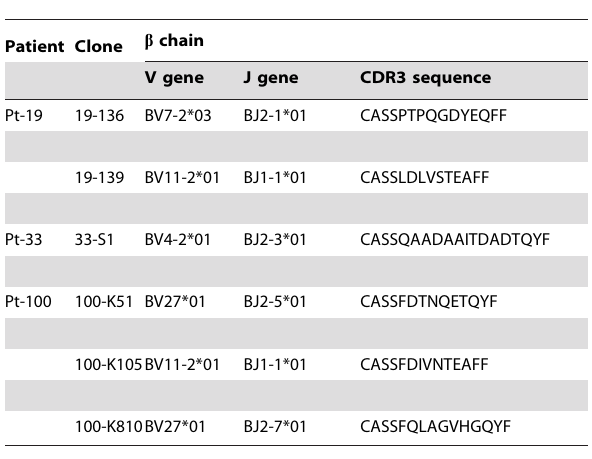
Table 2. TCR b composition of CD8 + T cell